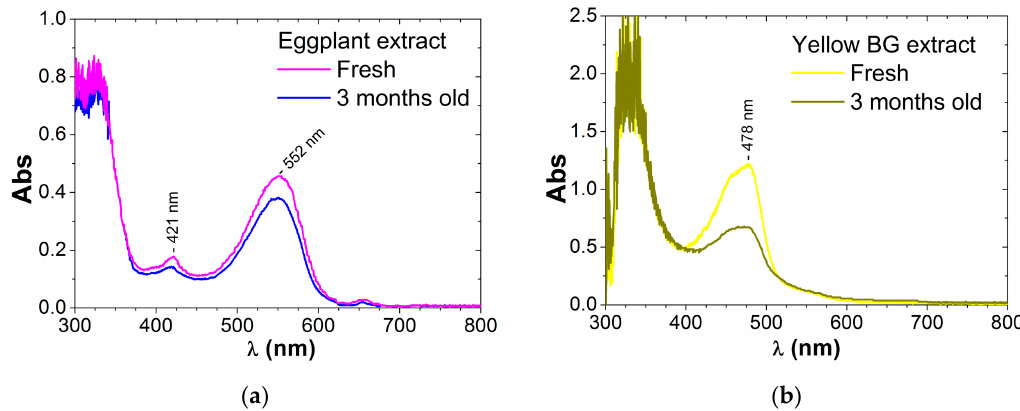
Figure 8. Extracts stability: ( a ) Eggplant extract with Solution 2: fresh, recently prepared (purple line) and 3 months later, preserved from air and light (blue line); ( b ) Yellow bougainvillea extract with Solution 2: recently prepared (yellow line) and 3 months old (dark green line).